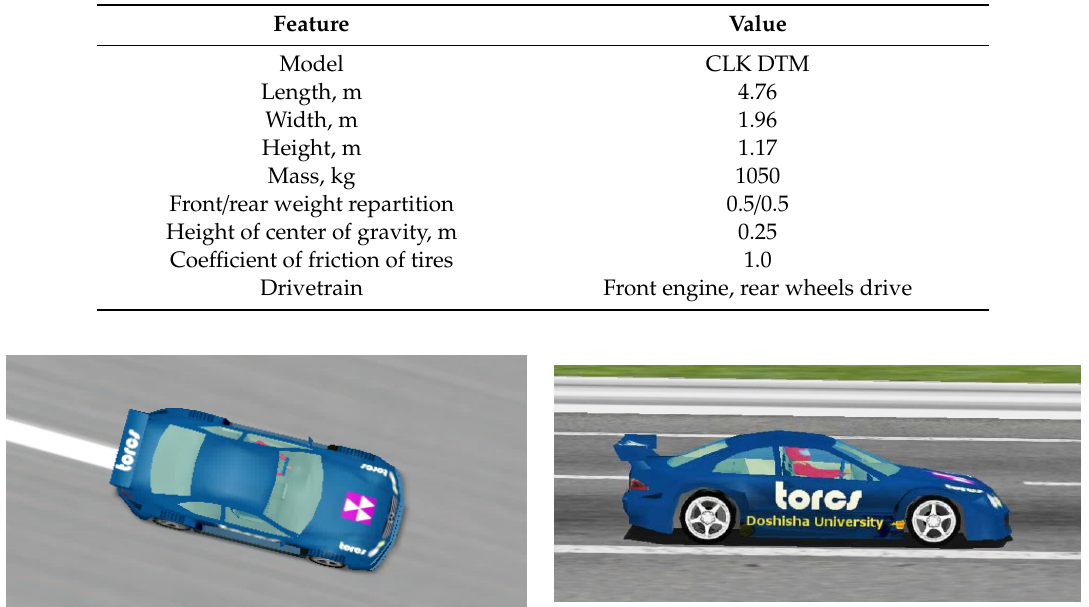
Table 1. Main parameters of the simulated car.